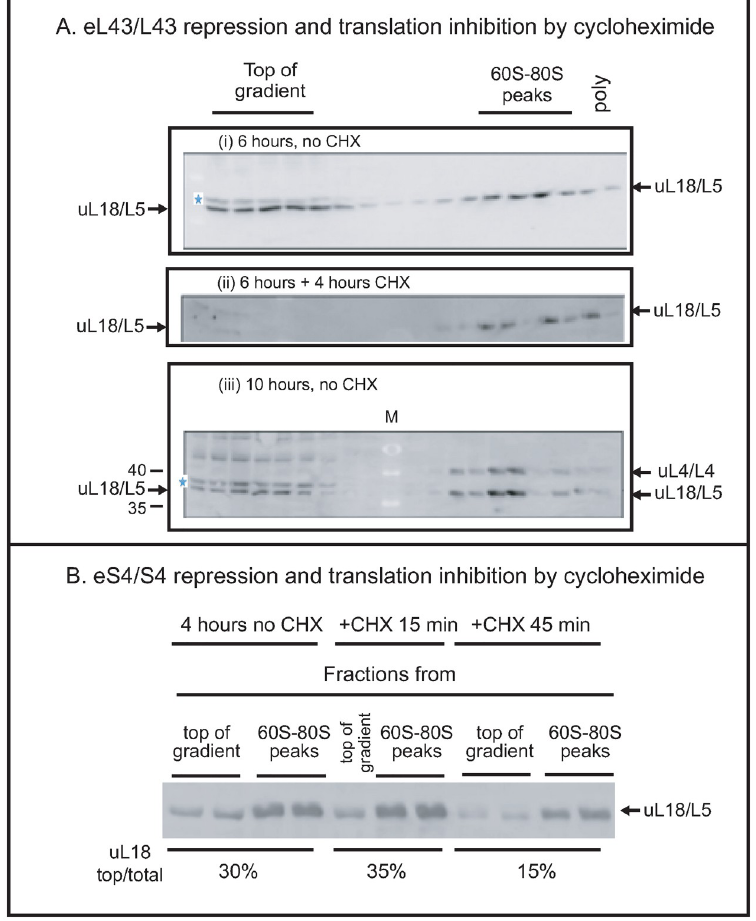
Fig 5. Maintenance of the extra-ribosomal uL18 pool requires protein synthesis. (A) Cycloheximide decreases the pool of extra-ribosomal uL18/L5 during the repression of a 60S r-protein gene. Six hours after shifting P gal -eL43/L43 from galactose to glucose medium, cycloheximide was added to an aliquot of the culture (final concentration: 100 μ g/ ml), while the culturing of another aliquot of the culture was continued without addition of the drug. Both aliquots were harvested 10 hours after the shift. Whole-cell extracts were analyzed by sucrose gradients and western blots of aliquots of all sucrose gradient fractions. (i) P gal -eL43/L43 6 hours after the shift of media, (ii) Pgal-eL43/L43 incubated with cycloheximide added 6 hours after the media shift and harvested 10 hours after the shift. (iii) P gal -eL43/L43 incubated for 10 hours in glucose without cycloheximide. All fractions from the top through the polysome region of the sucrose gradient are shown. (B) Cycloheximide also decreases the pool of extra-ribosomal uL18/L5 during the repression of a 40S r-protein gene. P gal -eS4/S4 was grown in galactose medium and shifted to glucose medium. Cycloheximide (100 μ g/ml) was added to the culture 6 hours after the shift and cells were harvested 0, 15 and 45 minutes after addition of the drug. Aliquots of one or two fractions from the top of the gradient and two fractions from the 60S-80S peaks were analyzed by western blots probed with anti-uL18/L5. Consecutive fractions from the top and the 60S-80S region of the sucrose gradient were shown. M Molecular weight markers in kD. 35 and 40 kD are identified. See S2 Fig for the full molecular weight